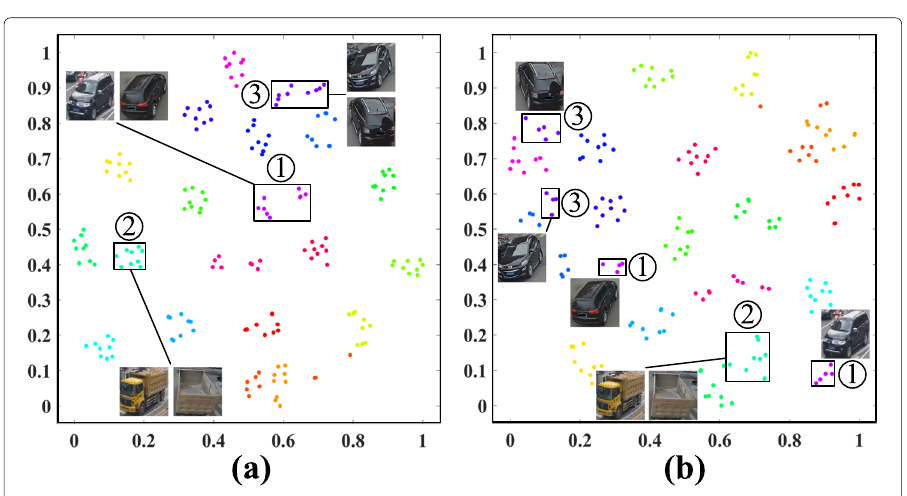
Fig. 4 Visualizations of features resulted from SDC-CNN-based student networks using a VRKD and not b using VRKD,